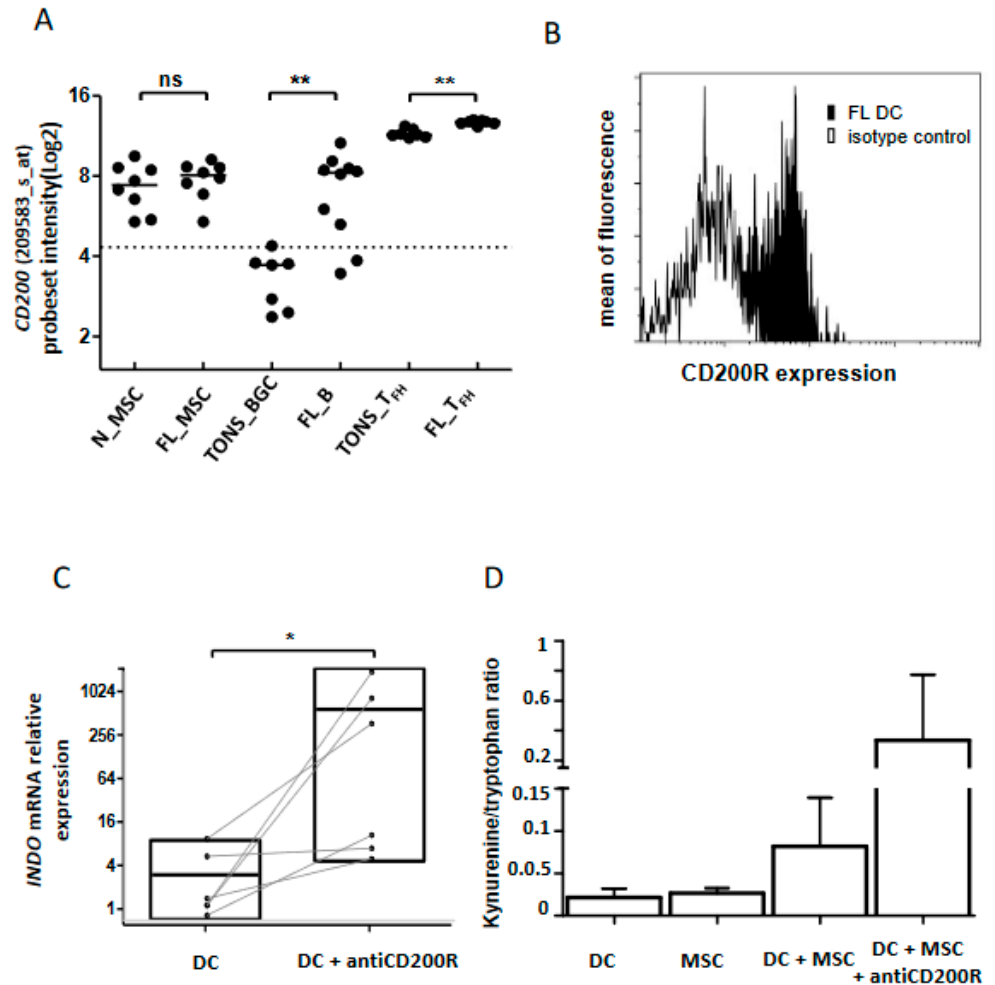
Figure 7. CD200 in FL tolerogenic niche. ( A ) CD200 mRNA expression analyzed by Affymetrix probeset intensity in stromal cells from non-tumoral ( n _STRO) or FL (FL_STRO) contexts, B lymphocytes from tonsil (TONS_BGC) or FL lymph node (FL_B) and Tfh lymphocytes from tonsil (TONS_Tfh) or FL lymph node (FL Tfh). ns: non-significant, ** p < 0.01; ( B ) Flow cytometry expression of CD200R on dendritic cells (DC) from FL lymph nodes (black histogram) compared to isotype control (white histogram). DC were phenotypically defined as CD3 neg CD19 neg CD335 neg CD11c pos HLA-DR pos CD14 neg viable cells. One representative graph out of three experiments is shown; ( C ) INDO mRNA expression by qRT-PCR of immature DC with or without CD200R in vitro stimulation (20 µg/mL) for 2 days ( n = 6), * p < 0.05; ( D ) IDO activity evaluated by kynurenine/tryptophan ratio on DC cultured or not with MSC and stimulated or not with anti-CD200R antibody (20 µg/mL) for 2 days.